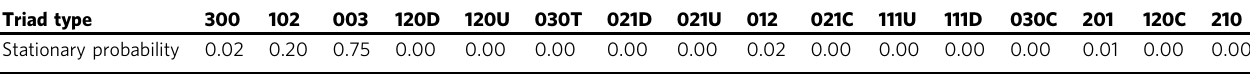
Table 3 Stationary distribution of the average Markov chain overall